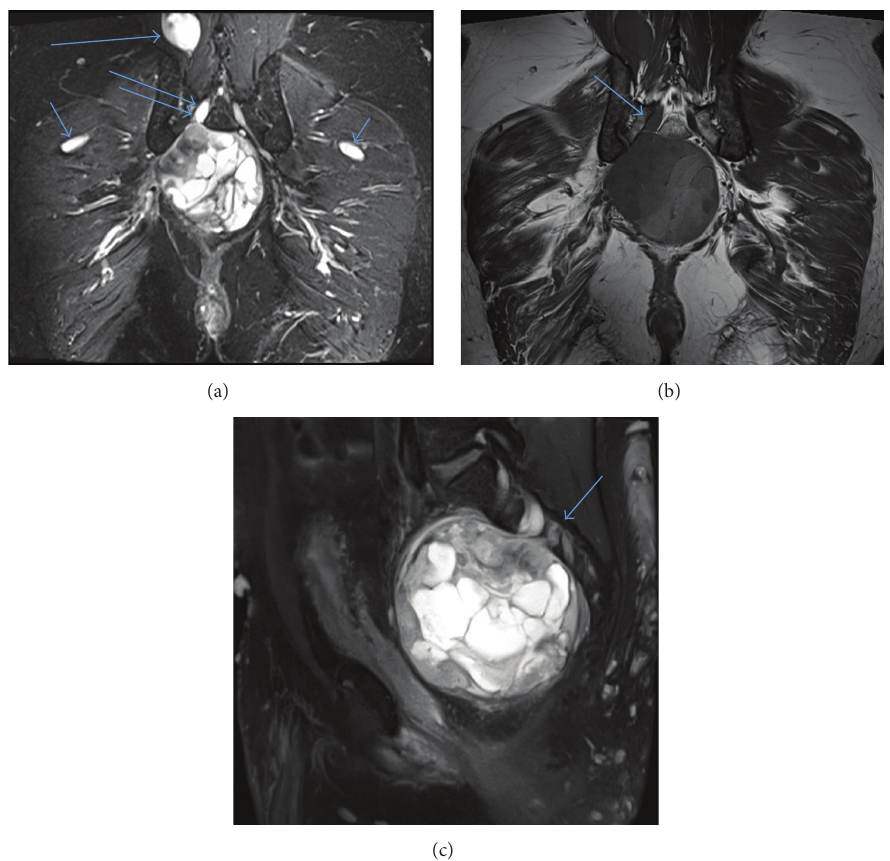
Figure 2: (a) Coronal STIR shows pelvic mass extending to the right S2 neuroforamen (long double arrows), right erector spinae/multifidus muscleneurofibroma (longbig arrow)and smallbilateral hipneurofibromas (shortsmallarrows). (b)CoronalT1shows pelvicmassextending to the right S2 neuroforamen (arrow). The other neurofibromas seen in (a) are not well visualized because their signal intensity is isointense to muscle. (c) Sagittal T2 FS shows pelvic mass (arrow points to right S2 neuroforamen).